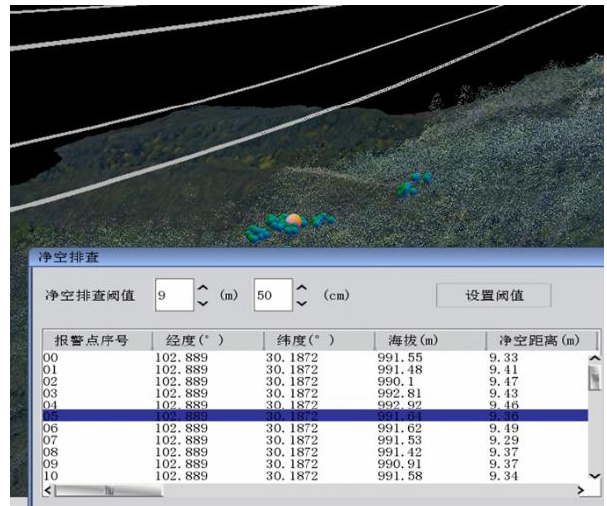
Figure 9. Investigation of safety distance of 3D inspection